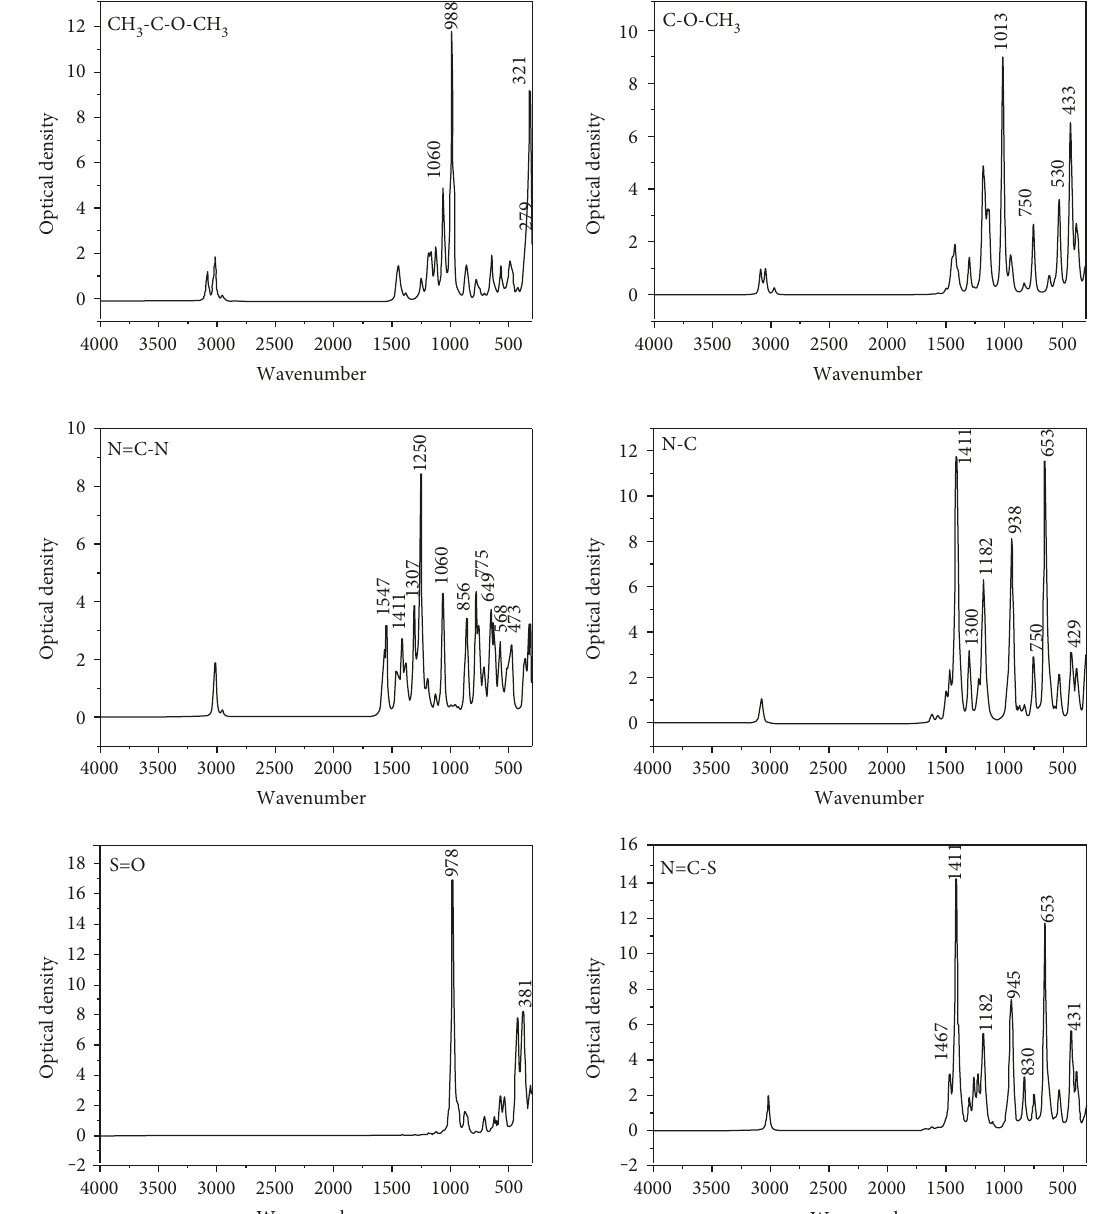
Figure 8: Calculated bands of selected omeprazole functional groups. These bands are taken from the calculation of the optimised OMP molecule. The whole calculated spectrum is presented in Figure